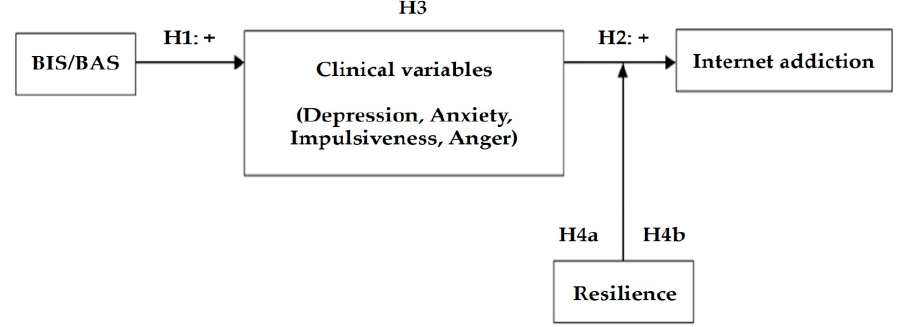
Figure 1. Hypothesized conceptual model. Note: BIS/BAS = Behavioral Inhibition System/Behavioral Activation System; H1 = hypothesis 1; H2 = hypothesis 2; H3 = hypothesis 3; and H4 = hypothesis